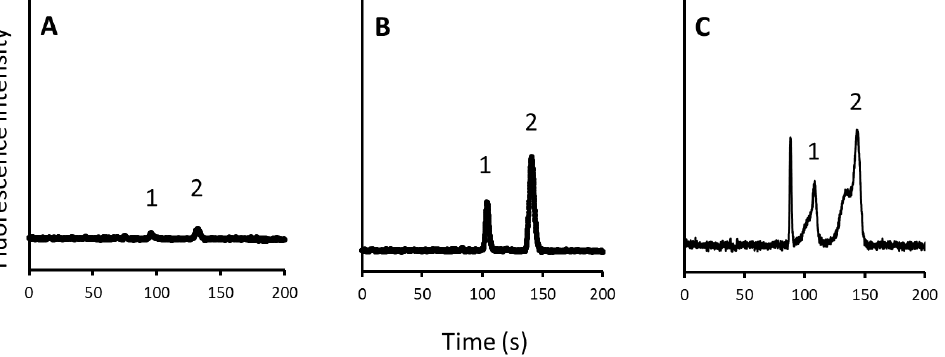
Figure 2. Chromatograms obtained for different valve switching times (( A ), 15; ( B ), 21; and ( C ), 24 s). Peak: 1, C525; 2, C545.